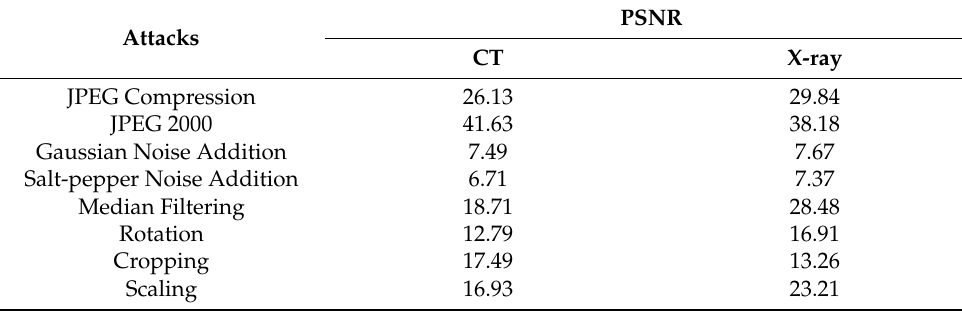
Table 3. Peak signal-to-noise ratio (PSNR) of the medical images after various attacks.